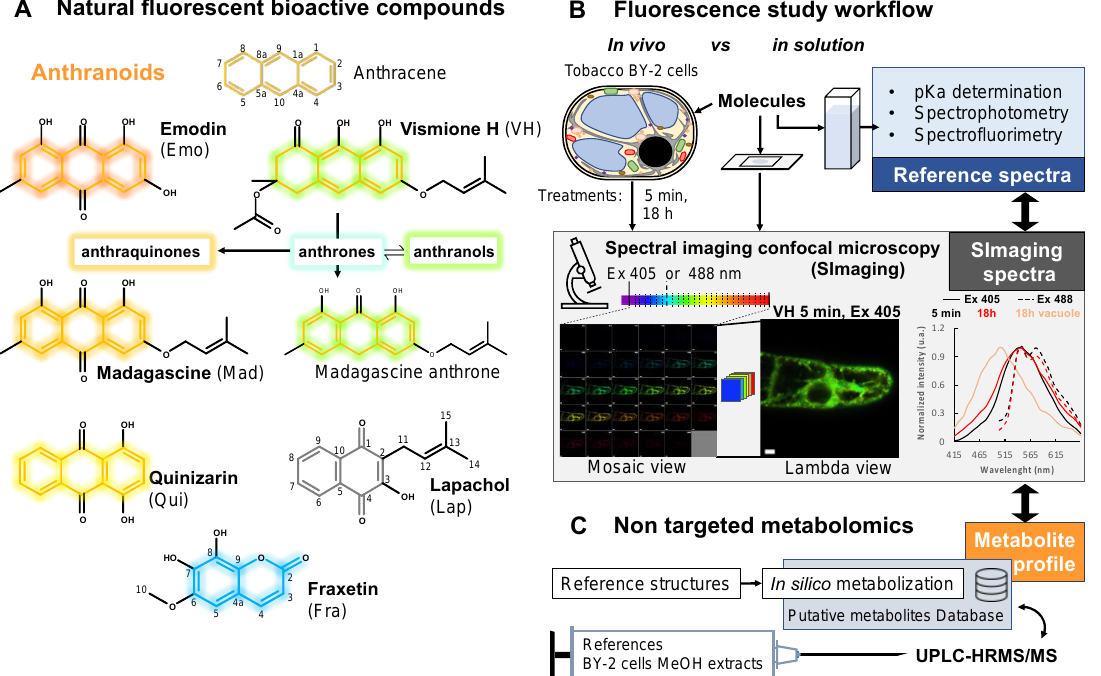
Figure 1. Overview of natural fluorescent bioactive anthranoids and the original approach used to study their localization and biotransformation in living cells. ( A ) Chemical structures of anthranoids characterized by the anthracene skeleton (orange skeleton) as compared to other phenolic compounds such as the naphthoquinone lapachol (Lap, grey skeleton) and the coumarin fraxetin (Fra, blue skeleton). In dimethylsulfoxide (DMSO), vismione H (VH) degrades quickly into anthrones (weak turquoise fluorescence) being in equilibrium with anthranol tautomers (strong green yellowish) and oxidized into anthraquinones such as emodin (Emo), madagascine (Mad) or quinizarin (Qui) (yellow to red fluorescence). ( B , C ) Spectral imaging and non-targeted metabolomic workflow to characterize biotransformation of fluorescent anthranoids in tobacco BY-2 cells. ( B ) Fluorescence of selected anthranoids is evaluated in solution, then these anthranoids (25 or 50 µ M) are used to feed cells for confocal spectral imaging microscopy observations at 5 min and 18 h after feeding. ( C ) Non-targeted metabolomics workflow implementing high-resolution mass spectrometry analysis of methanolic extracts from cells characterized in ( B